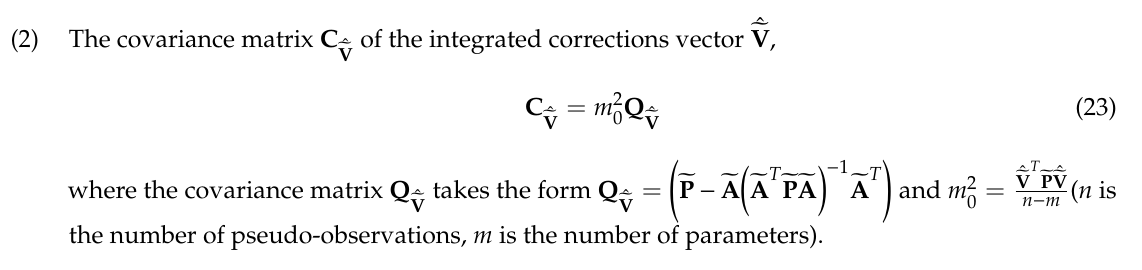
Table 1. List of theoretical coordinates of controlled points.